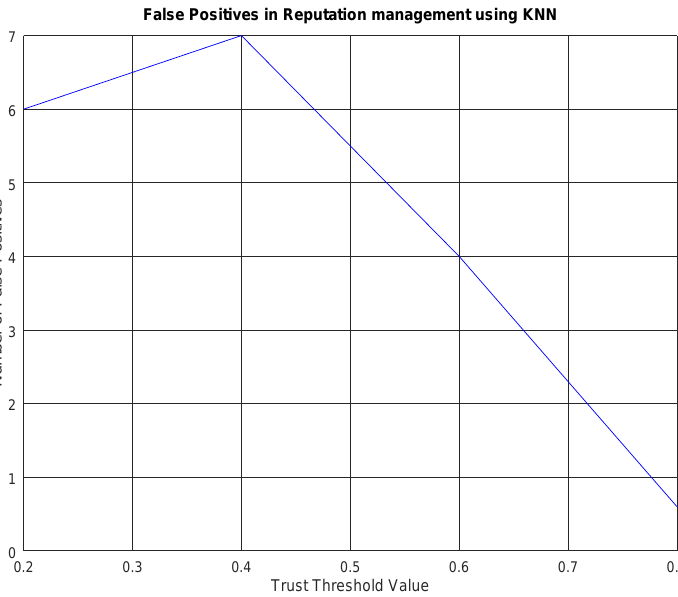
Figure 12. False positives in reputation management using